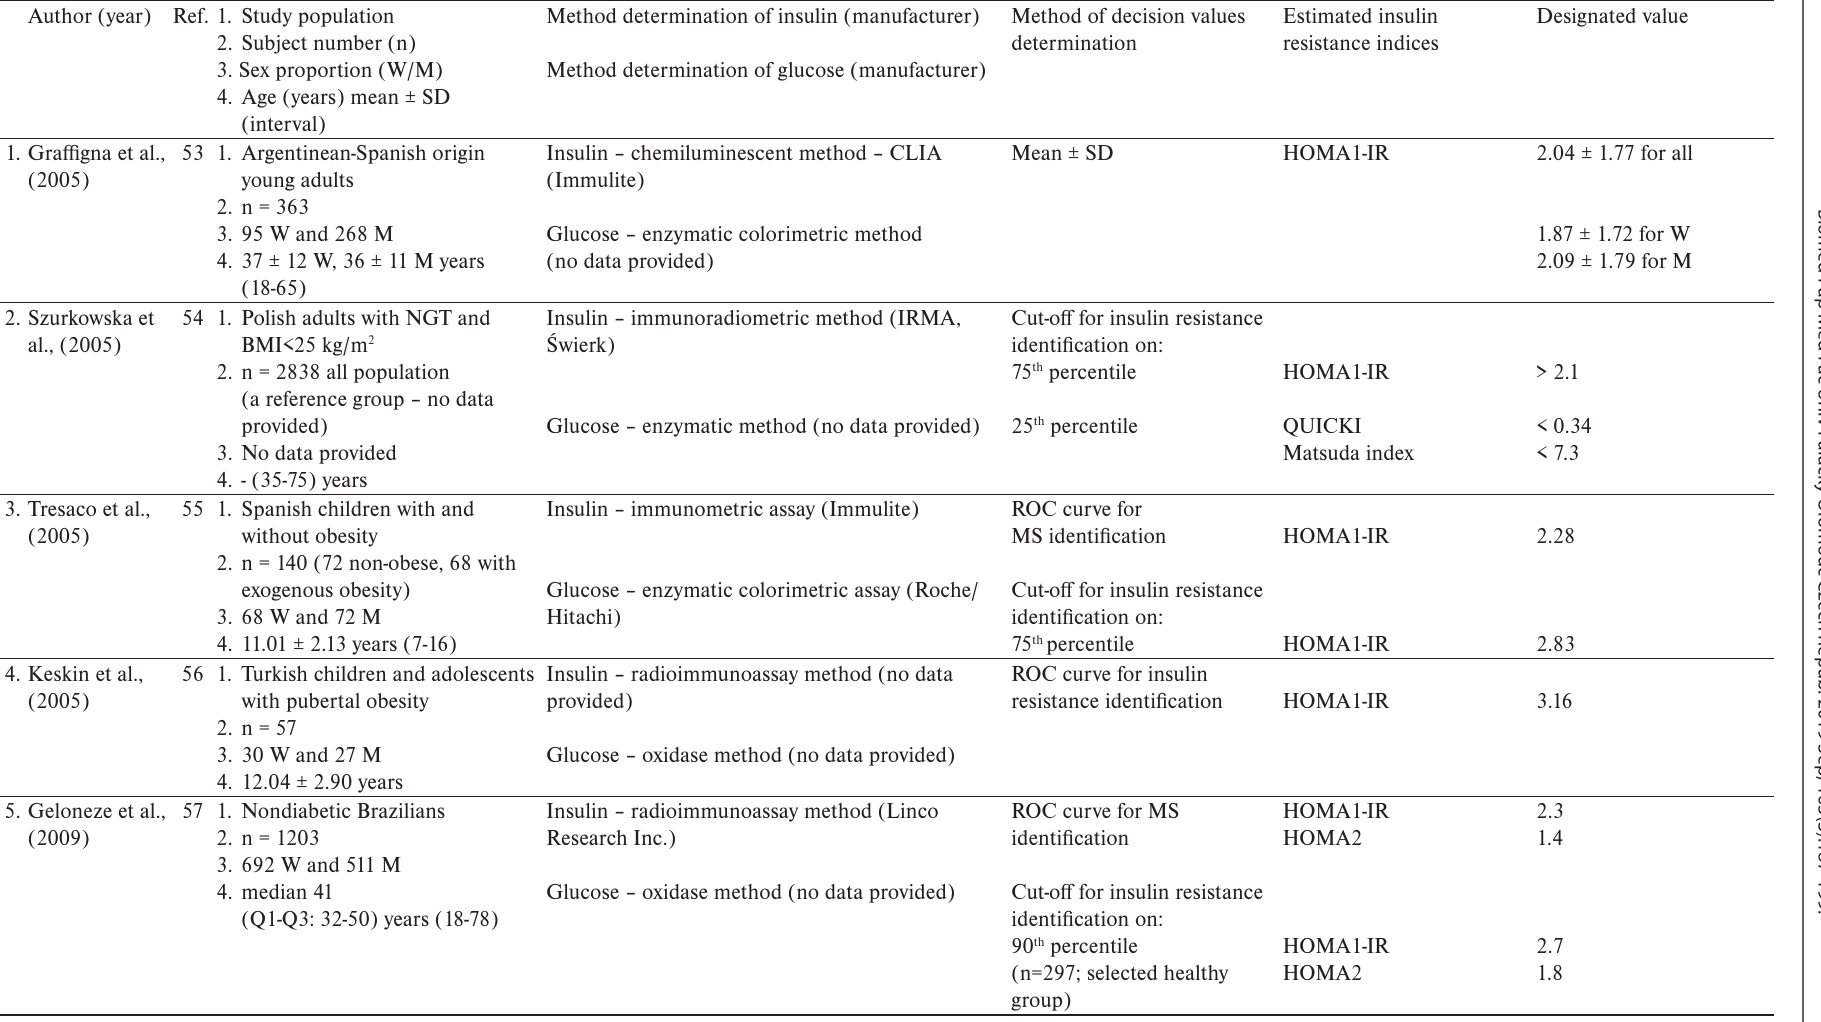
Table 2. The values of insulin resistance indices designated for different populations using different classification